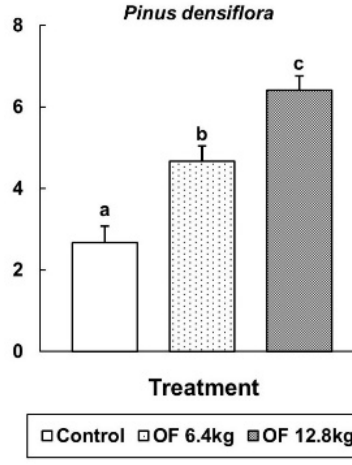
Figure 5. Height growth response of sample plants in control (fresh coal mine debris) and ameliorated plots (OF 6.4 ton and OF 12.8 ton). Control: fresh coal mine debris plot, OF 6.4 ton: plot ameliorated treating organic fertilizer of 6.4 ton/ha, OF 12.8 ton: plot ameliorated treating organic fertilizer of 12.8 ton/ha, Reference: natural forest soil. Each bar expresses the mean and standard error of the mean. Tukey’s honestly significant difference (HSD) test was conducted on each of the parameters that showed a statistically significant difference among the three types of treatments at α = 0.05; the means with the same alphabetical character (in superscript) for each parameter are not different from each